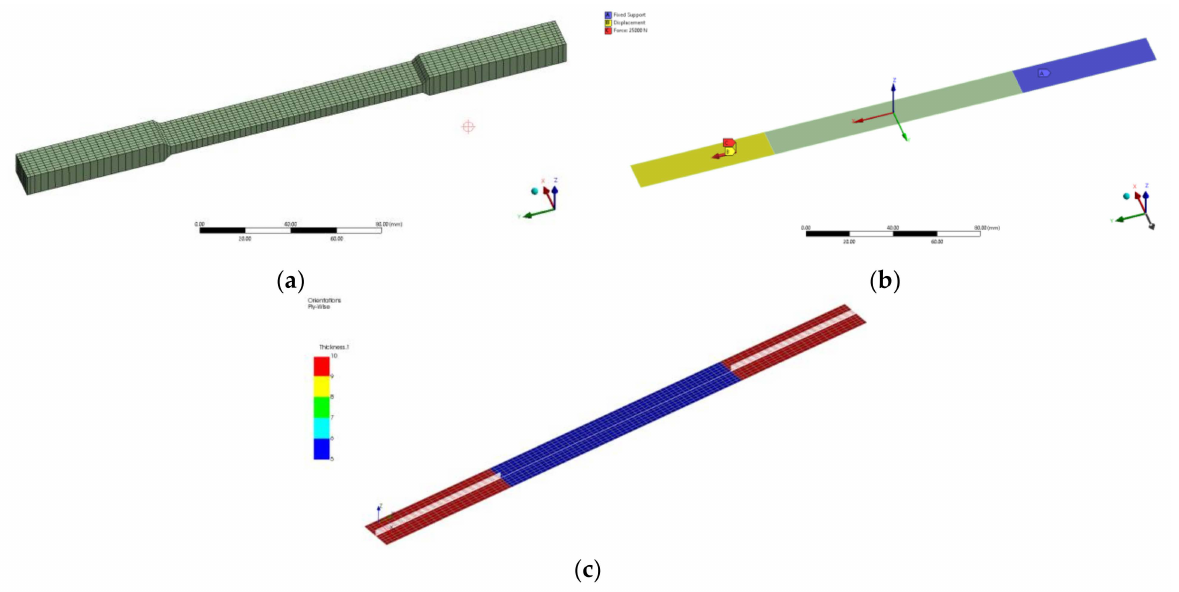
Figure 2. Tensile test FE model: ( a ) mesh; ( b ) boundary conditions; ( c ) ACP layup